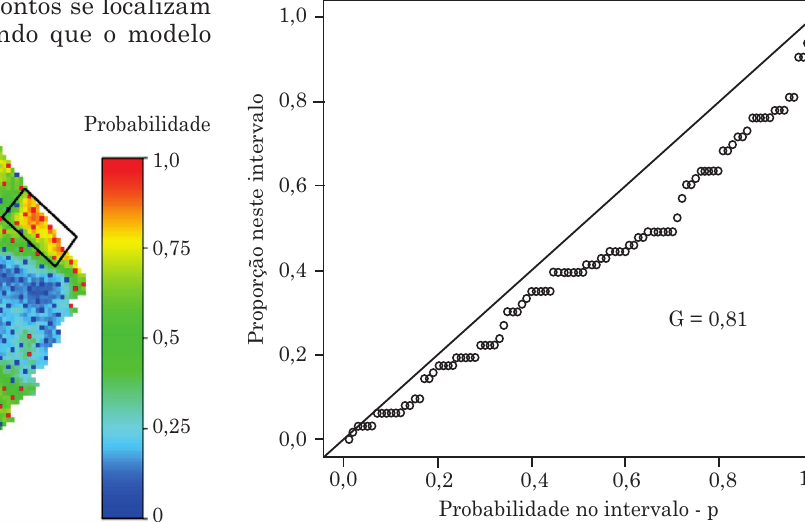
Figura 7. Mapa de probabilidade de o teor de fósforo lábil não exceder a 6 mg dm -3 .